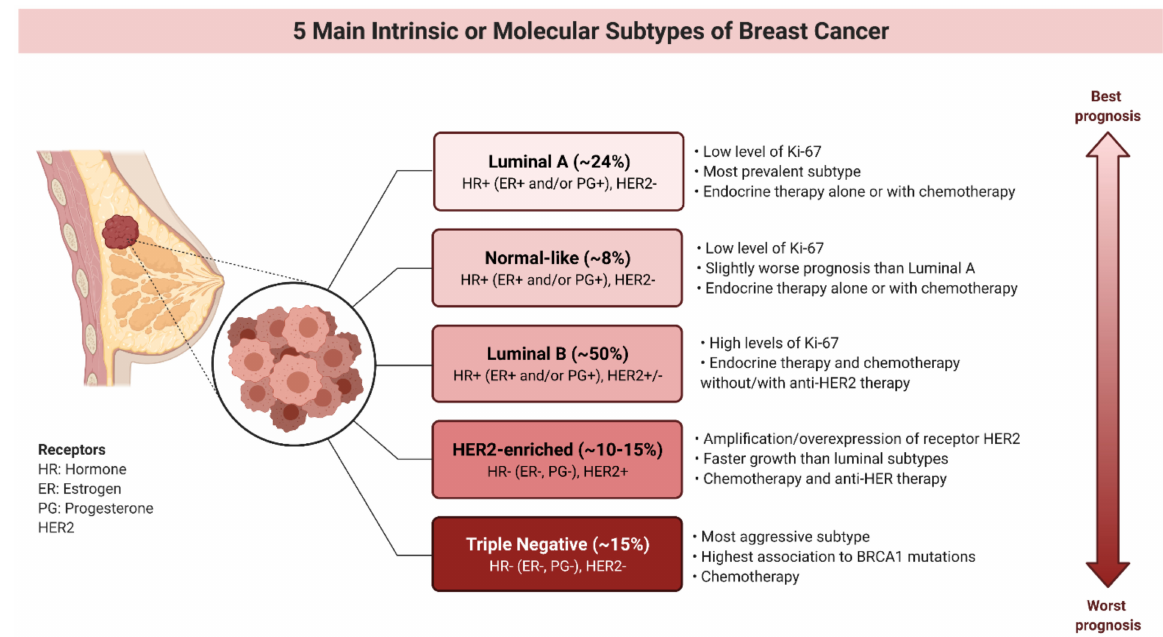
Figure 1. 5 main intrinsic or molecular subtypes of breast cancer (BC) (ER-estrogen receptor, PG-progesterone receptor, HER2-human epidermal growth factor receptor, Ki67-proliferation index marker)